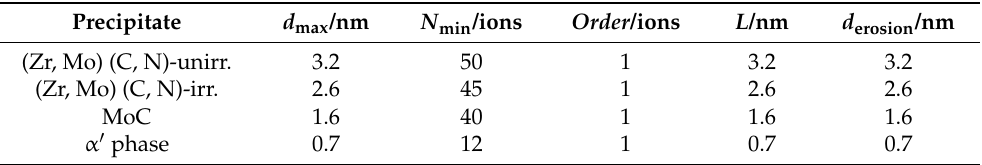
Table 1. The relevant parameters of different precipitates for “Cluster Analysis” in IVAS 3.6.8 software.